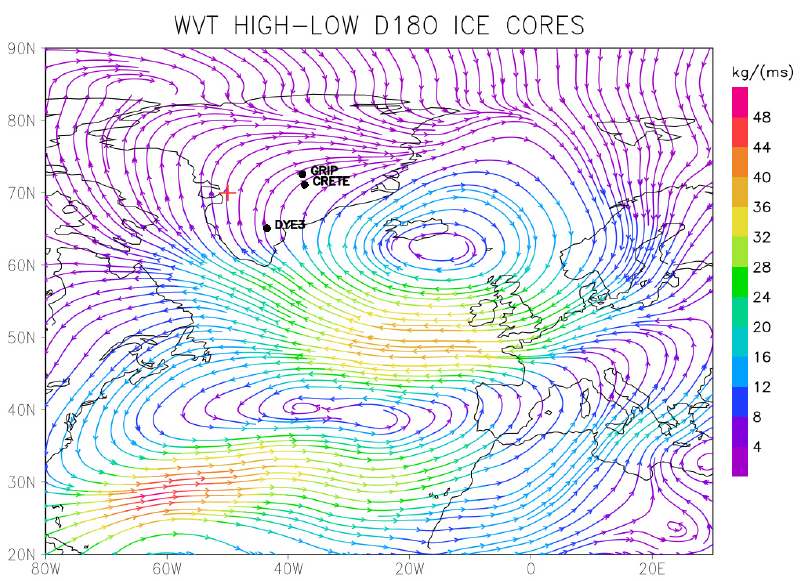
Figure 1. The difference between composite map of vertically integrated water vapor transport (WVT) for high and low ice core δ 18 O winters during 1851 to 1973 (see text for details). Colors indicate the magnitude of the WVT anomalies in kg/(ms) while arrows its direction. The red plus sign indicates the grid point used to calculate the probability distribution of daily meridional WVT and the black dots depict the ice core sites.